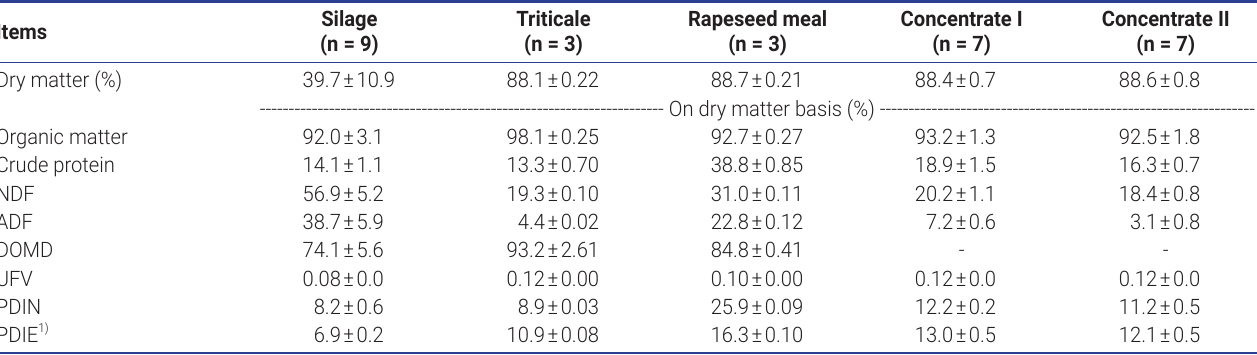
Table 1. Chemical composition and nutritional value of the ingredients of experimental diets